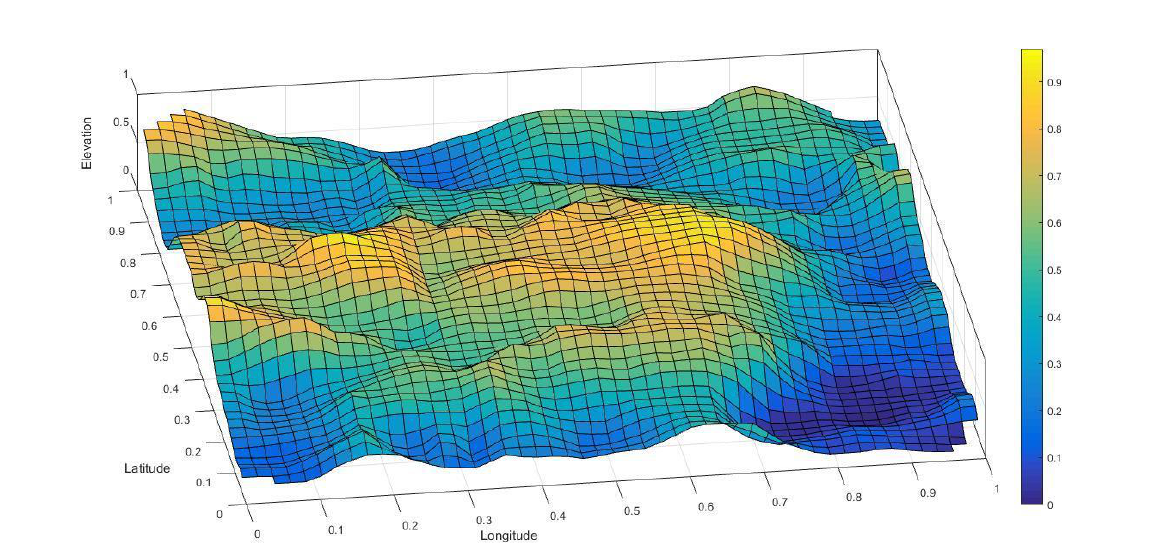
Figure 5. 3D terrain modelling from elevation data using homotopy continuation based on piecewise linear spline interpolation.